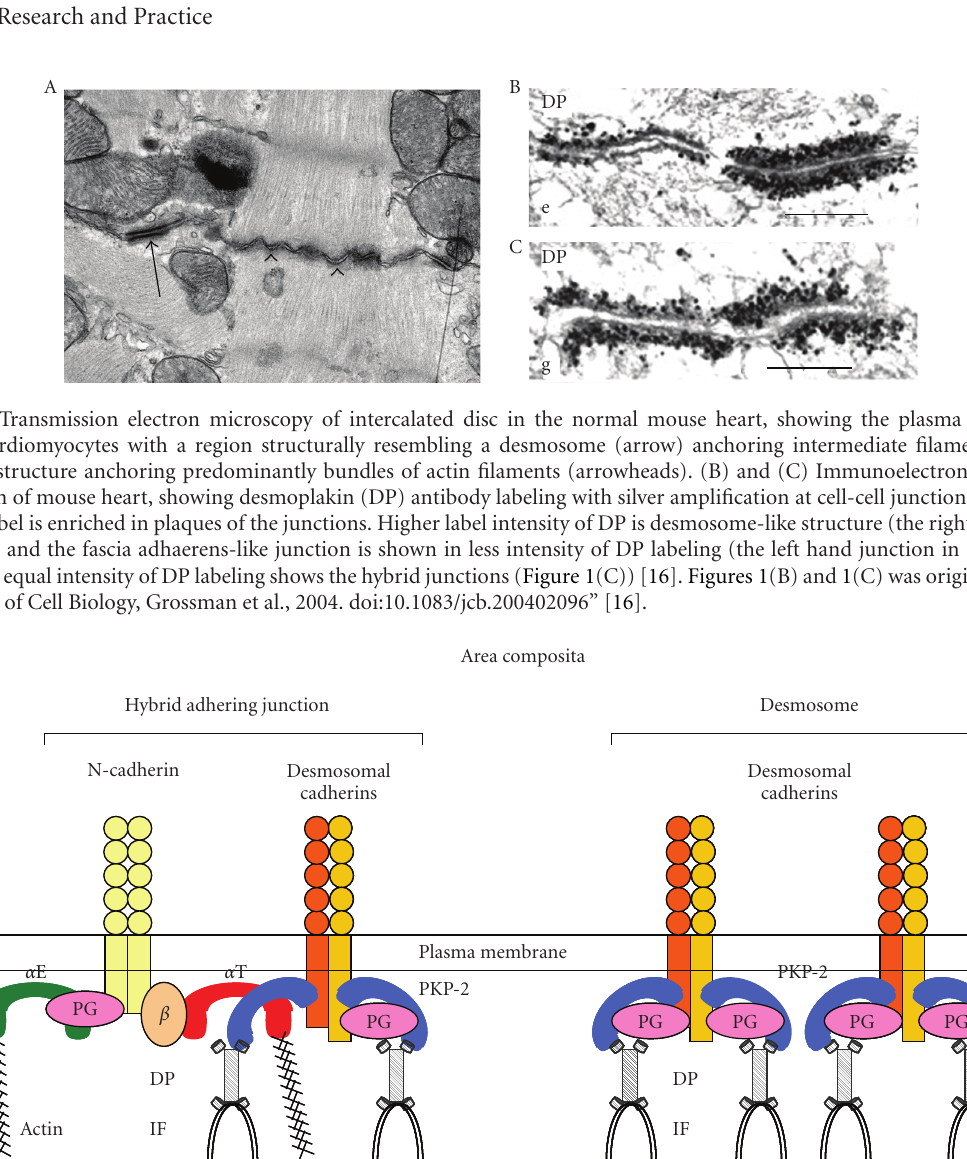
molecular evidence that α T-catenin, a unique molecule of adherens junction, functions as cytoskeletal linker protein that specifically brings the desmosomes and adherens junc- tions together in the intercalated disc of the heart